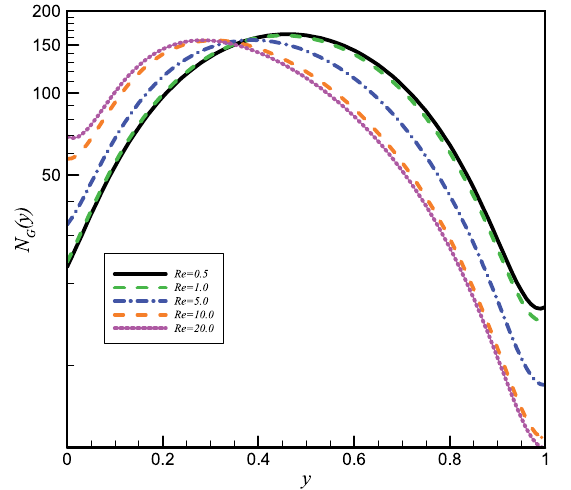
Fig. 17. Variation of entropy generation parameter, N G ( y ) , with respect to y for different values of x − velocity of the moving plate.